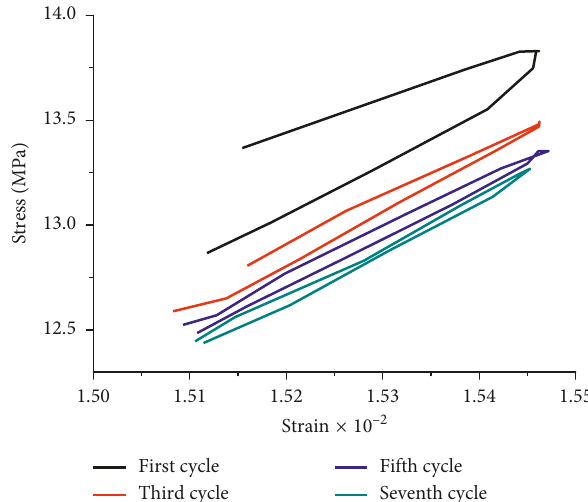
Figure 10: Four stress-strain curves showing the hysteresis loops for the initial several loading-unloading cycles at the beginning of a cyclic loading test.